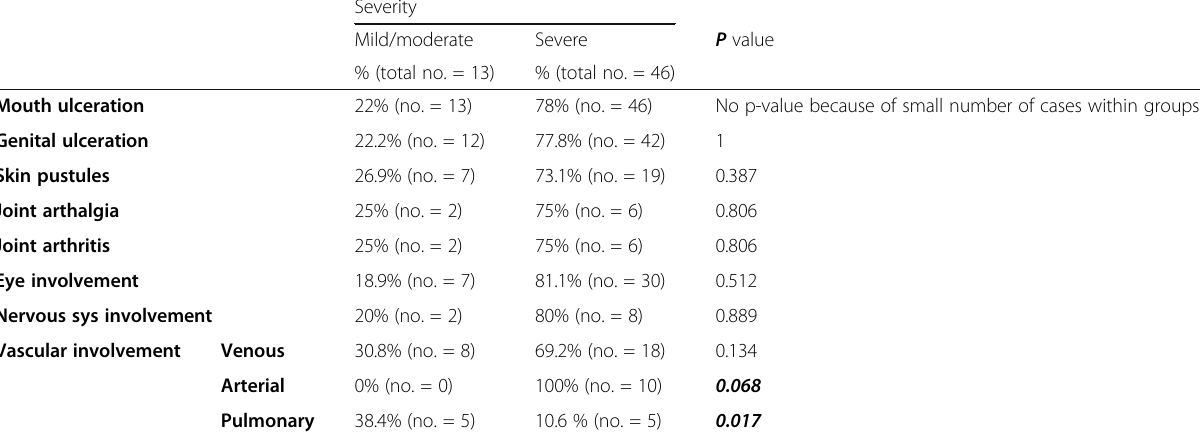
Table 5 Association of severity level of BD with clinical picture of BD